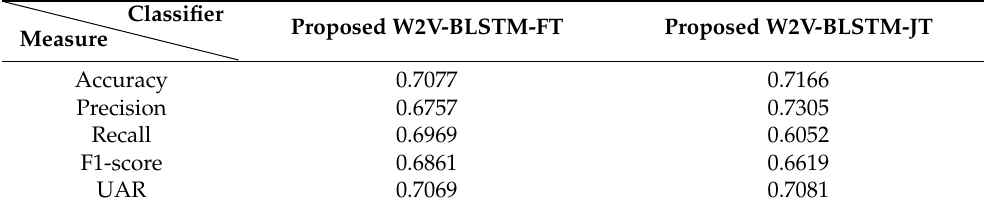
Table 3. Classification results of the proposed W2V-BLSTM-FT and W2V-BLSTM-JT classifiers using speech waveforms as input